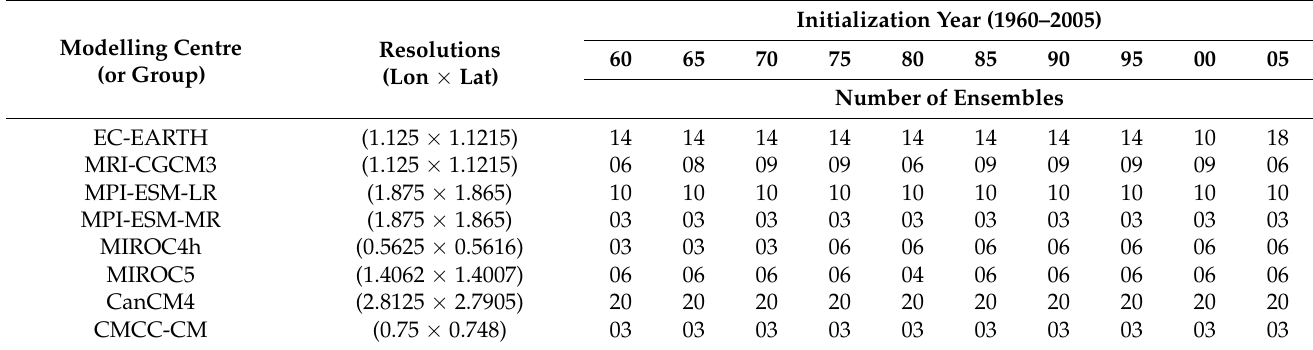
Table 1. List of models (GCMs) used as additional regressors in this